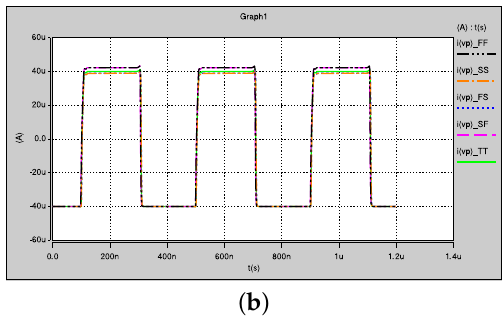
Figure 8. PVT variations for Figure 6 at 5 MHz: ( a ) DC; and ( b ) time domain.